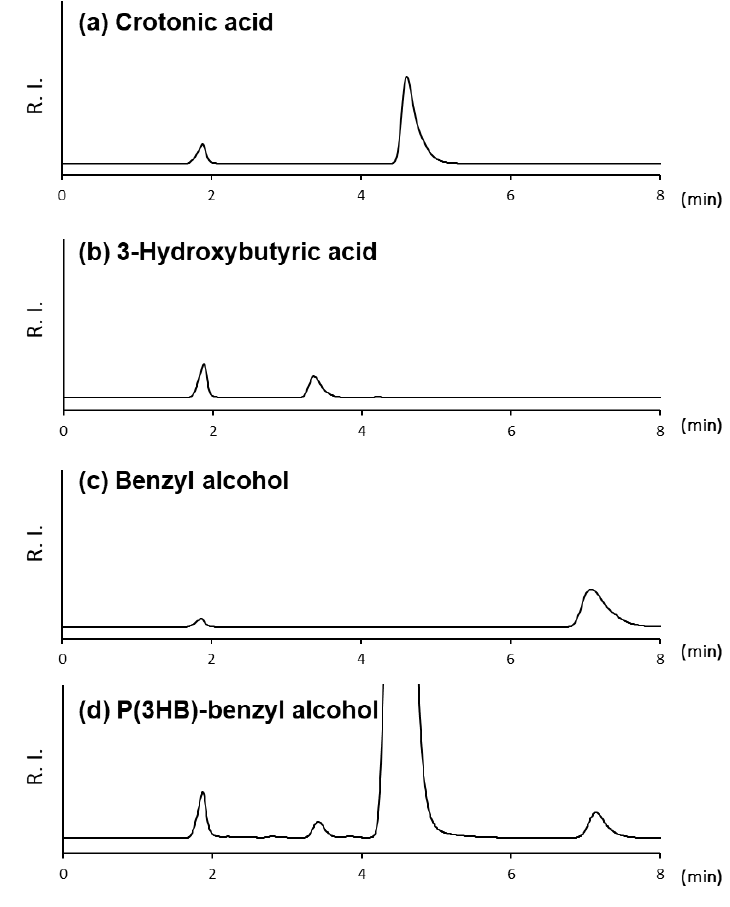
Figure 2. HPLC chromatograms recorded at 210 nm. ( a ) Crotonic acid; ( b ) 3-hydroxybutyrate; ( c ) benzyl alcohol; and ( d ) alkaline-treated P(3HB) with benzyl alcohol end. R. I. means relative